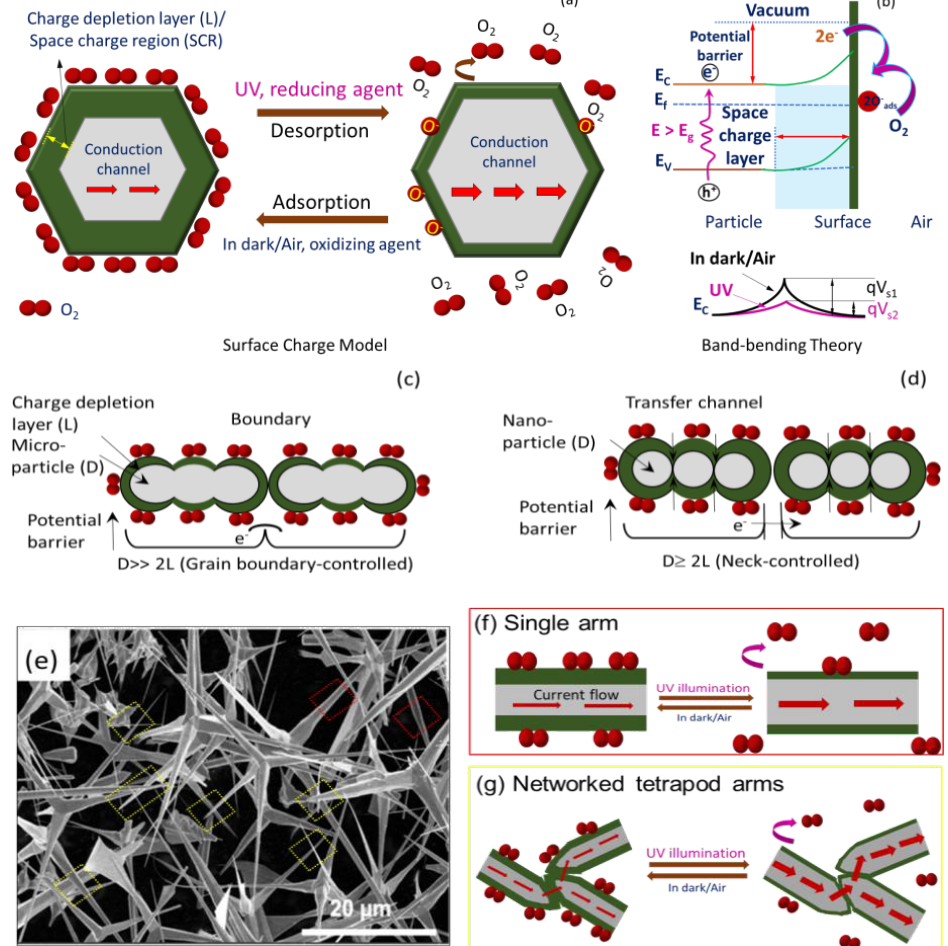
Figure 5. Schematic to describe sensing in dark/air and under UV illumination for ZnO using ( a ) space charge model and ( b ) band-bending theory. Proposed UV sensing mechanism based on space charge model for ( c ) microparticle ZnO – MP; D>> 2L, ( d ) nanoparticle ZnO – NP; D ≥ 2L. ( e ) SEM image of T – ZnO; D >> 2L and sensing mechanism of ( f ) single arm (red) and ( g ) networked tetrapod T – ZnO (D >> 2L) arm (yellow) morphology.